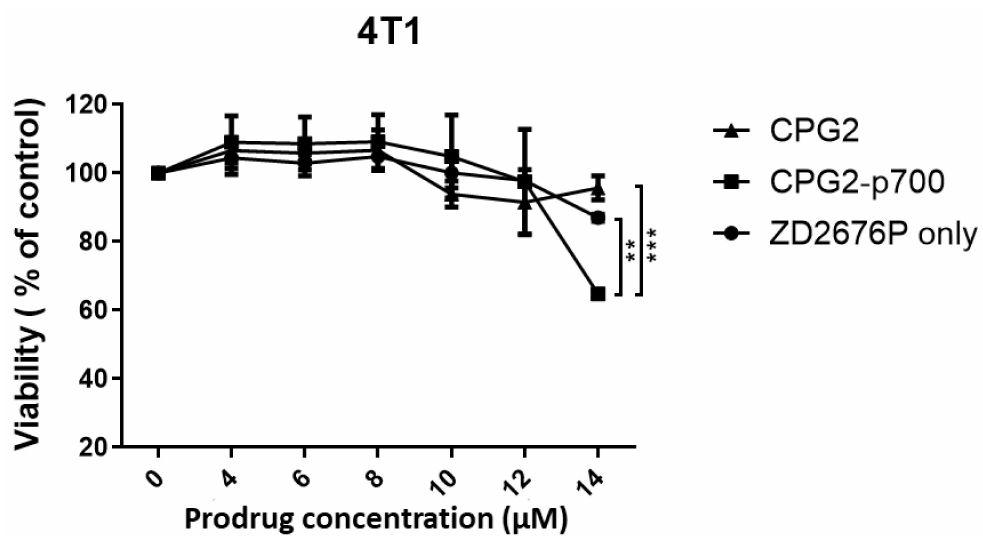
Figure 6. The effect of increasing concentrations of prodrug ZD2676P on the viability of the mouse breast cancer cell line 4T1 in the presence or absence of CPG2 or CPG2-p700. Data are means ± SEM; n = 3 (** = p < 0.01, *** = p < 0.001) indicates significance, two-way ANOVA, multiple comparison